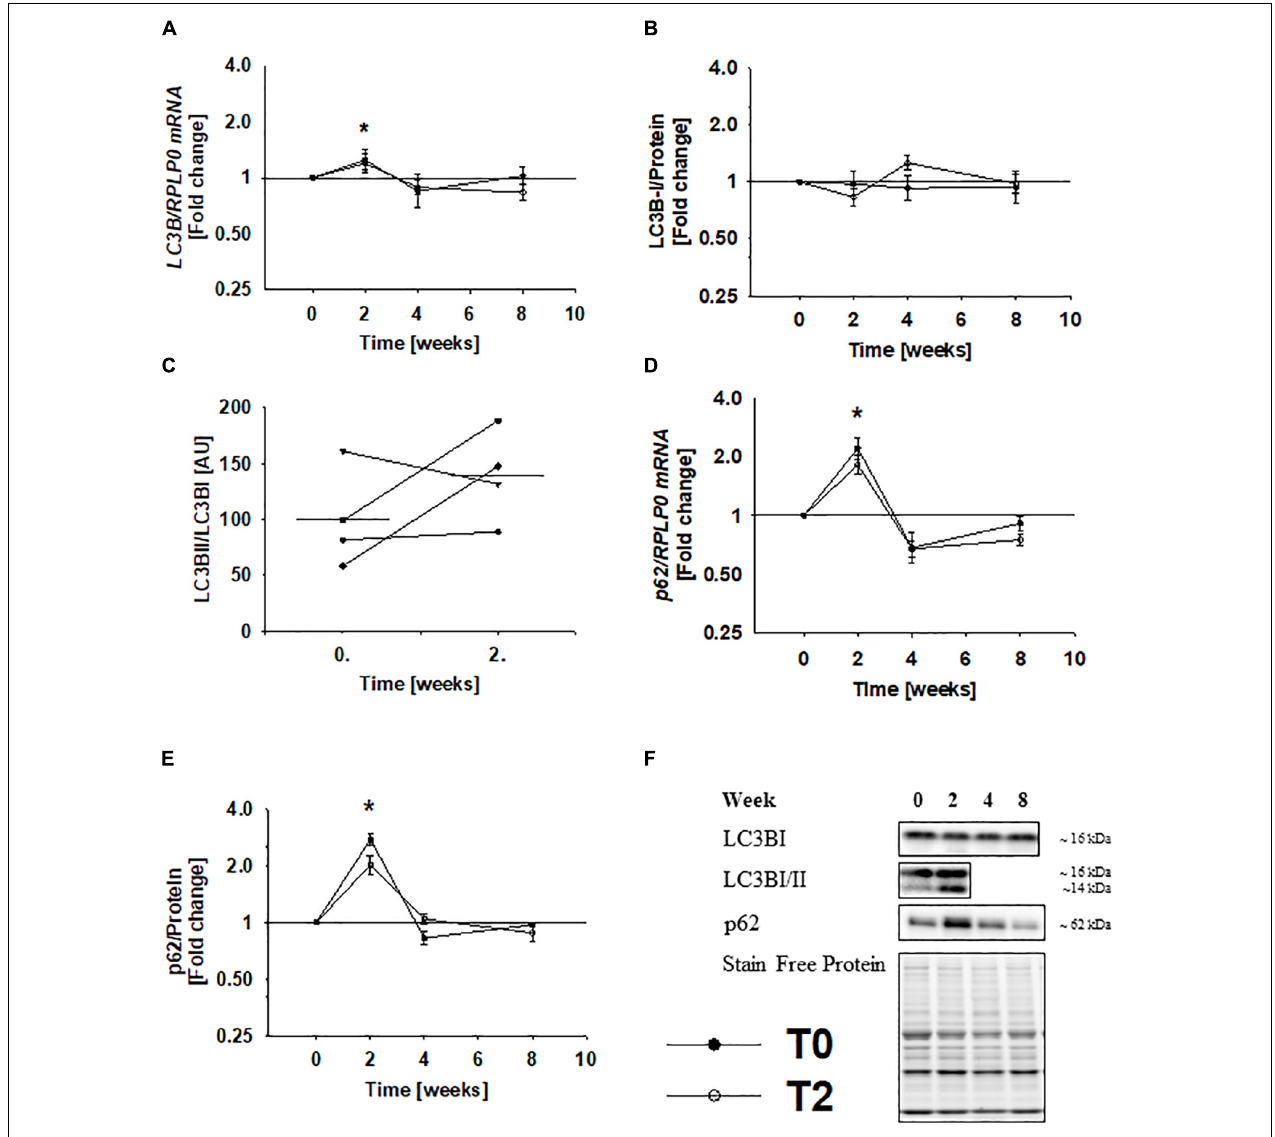
FIGURE 4 | Gene and protein expression of LC3B and p62 increases during immobilization and returns to baseline levels during rehabilitation. mRNA expression of LC3B increased during immobilization and returned to baseline values during rehabilitation (A) , while protein expression of LC3B remained unchanged during immobilization and rehabilitation (B) . After initial problems with detection of LC3B-II, we extracted proteins from the remaining biopsy material using a lysis buffer containing stronger detergents. This allowed us to examine LC3B lipidation before and after immobilization in four subjects, and LC3B lipidation increased in three of those subjects during immobilization (C) . Protein and mRNA expression of p62 increased during immobilization (and decreased to baseline values during rehabilitation (D,E) . Values are geometric means ± back-transformed SE. ∗ Post hoc test showed significant change during immobilization. Representative western blots (F) . Based on the applied molecular standards, approximated molecular weights are indicated on the right. Filled symbols represent subjects from T0 and open symbols represent subjects from